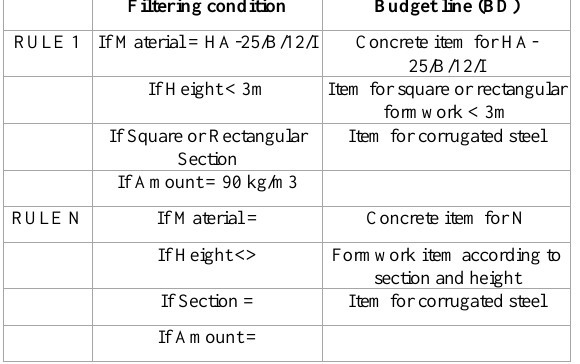
Table 3. Preparation of Rules for the fulfilment of conditions of filtering of characteristics and relationship with the